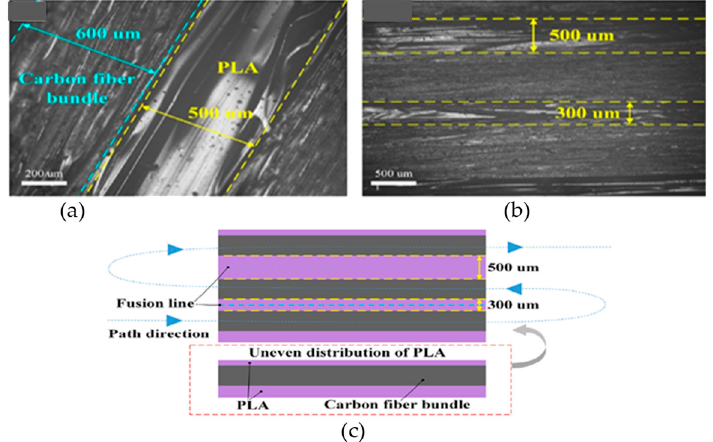
Figure 11. Surface morphology of 3D printed carbon fiber / PLA composite: ( a ) micrograph of carbon fiber bundle and PLA resin; ( b ) micrograph of PLA width between carbon fibers; and ( c ) schematic of the uneven distribution of PLA. Adapted from [153], with permission from © 2016 Elsevier.